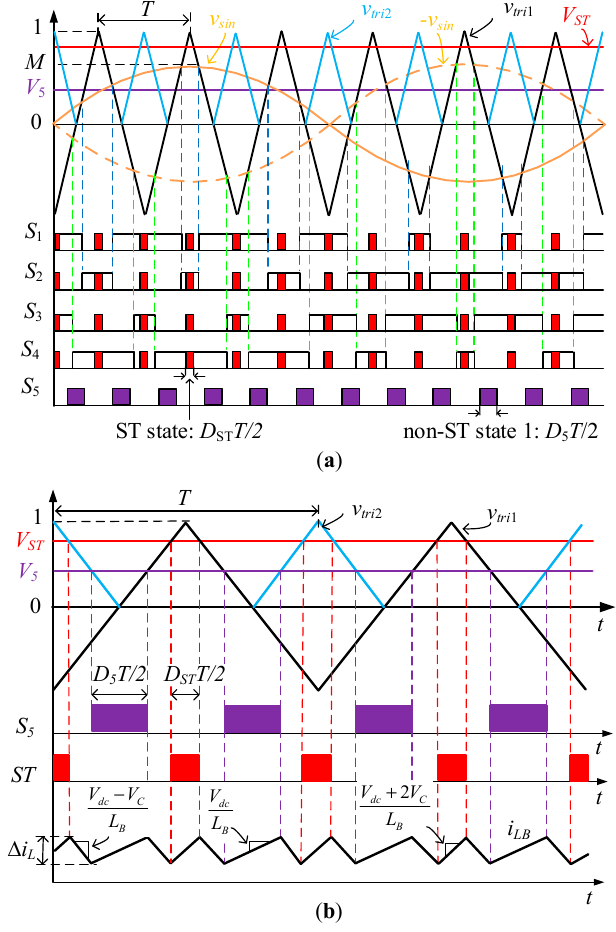
Figure 3. Pulse-width modulation (PWM) control technique for the proposed single-phase inverter. ( a ) Signal generation and ( b ) enlargement waveforms.